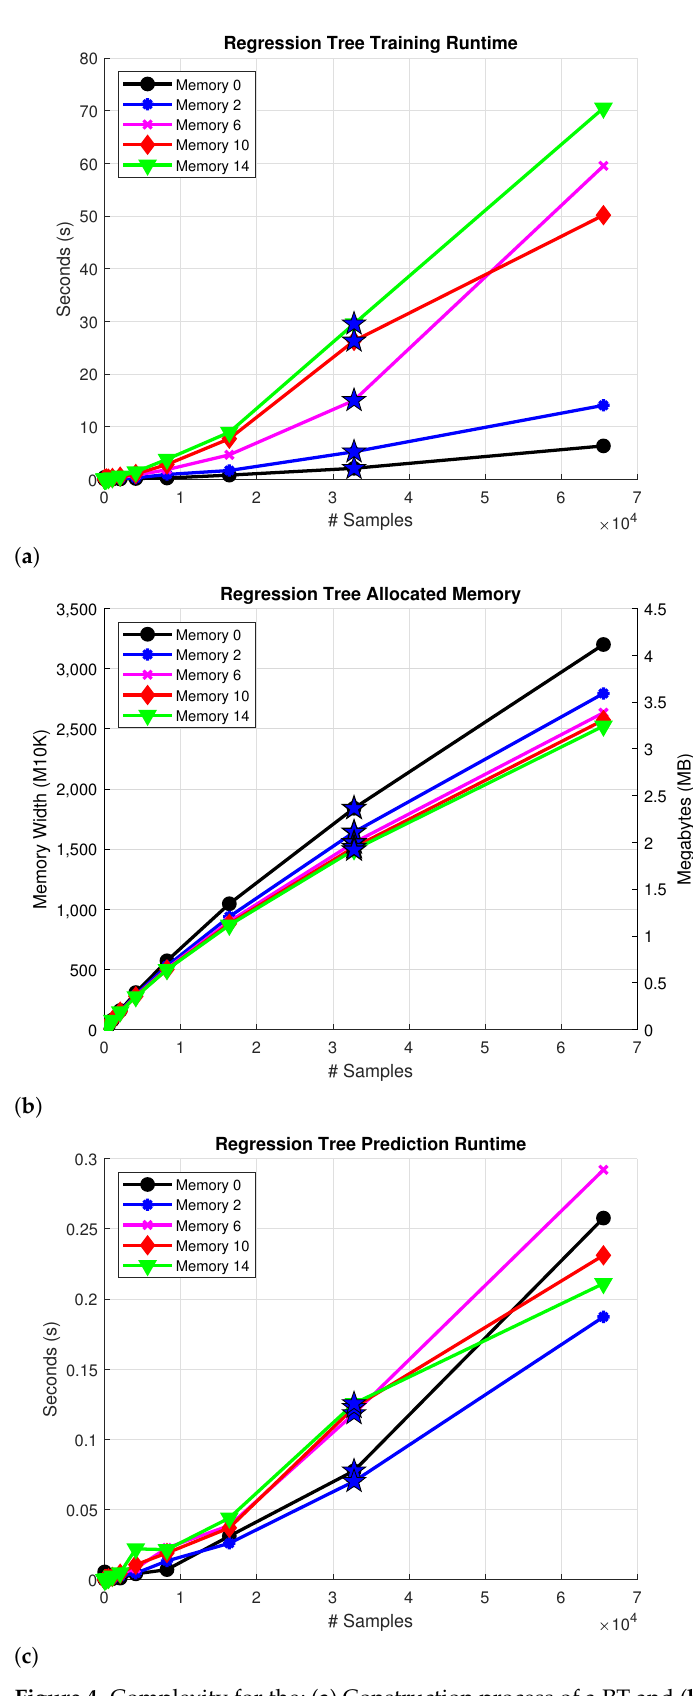
Figure 4. Complexity for the; ( a ) Construction process of a RT and ( b ) Allocated memory of the RT model ( c ) Prediction runtime of the model. The star denotes the Case 2 approximation